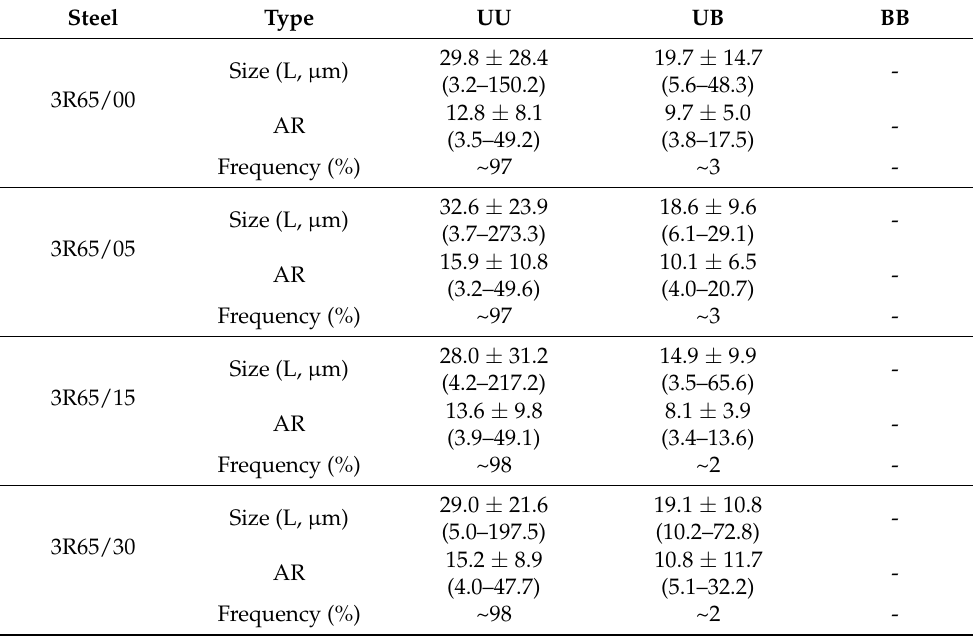
Table 16. The classification of different types of NMIs in the sample of 3R65 using Method